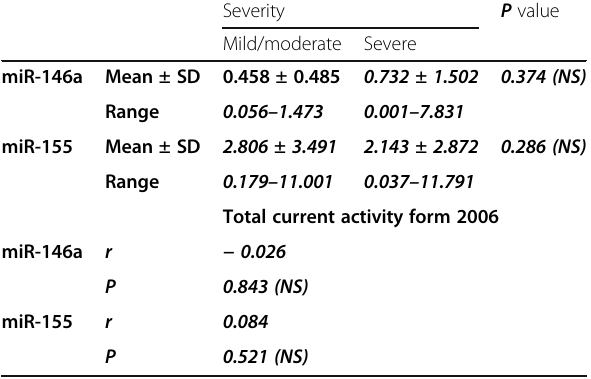
Table 9 Correlation between the expression of miR-146a and miR-155 with BD severity level and activity form BDCAF Severity P